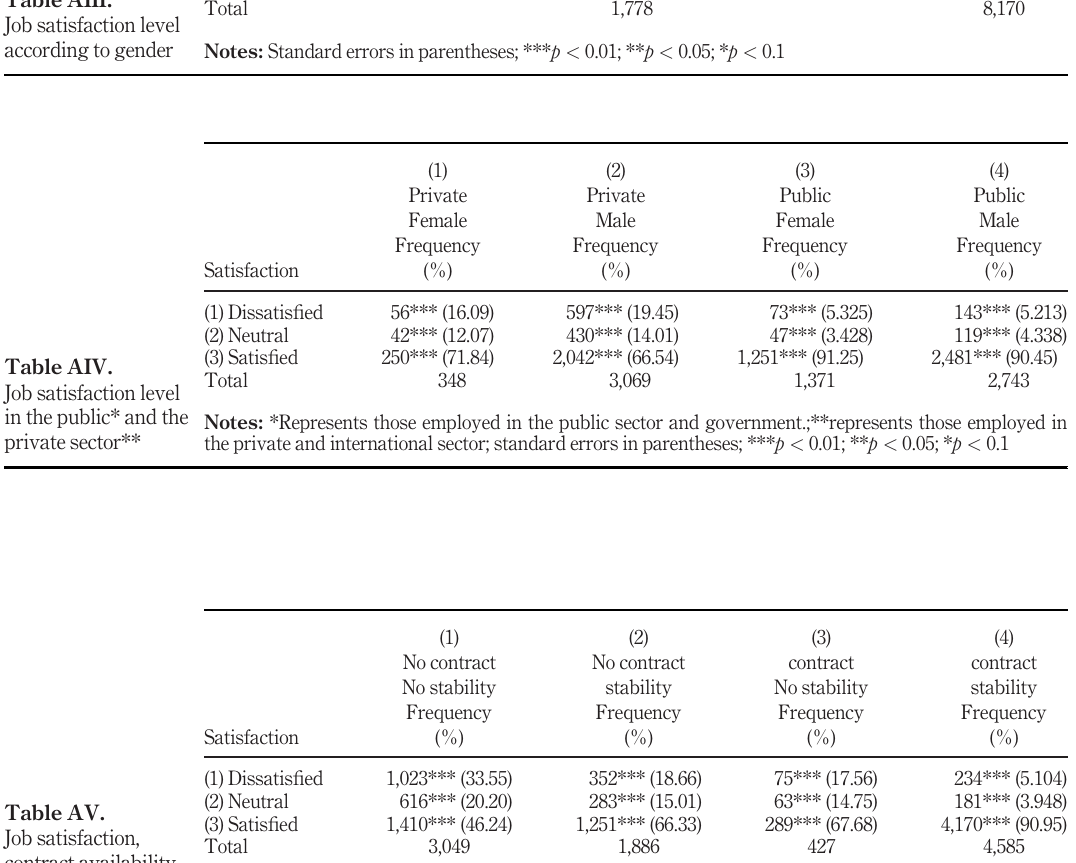
Table AV. Job satisfaction, contract availability and